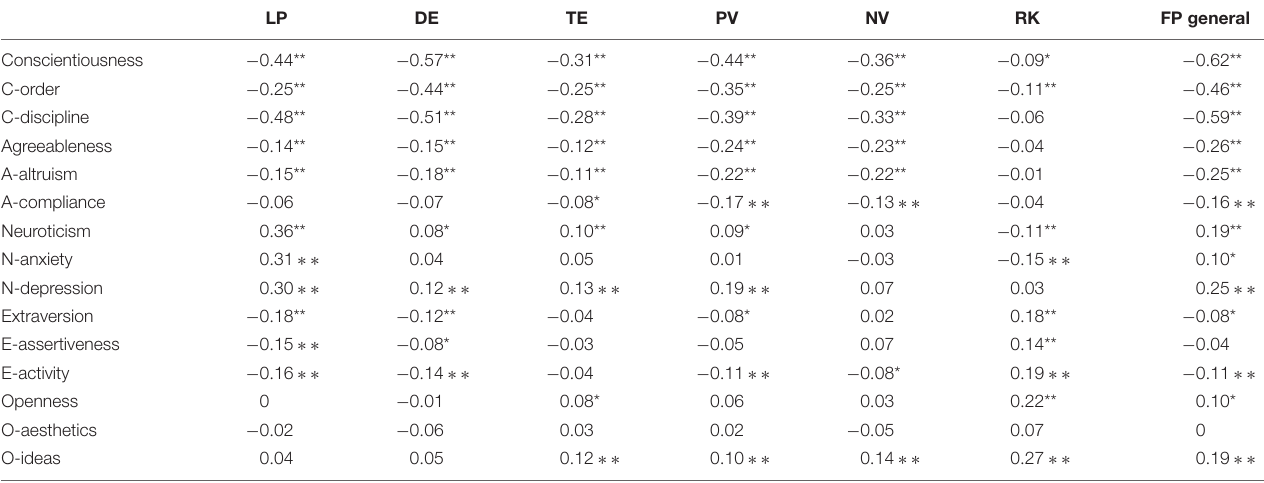
TABLE 6 | Correlations among BFI (traits and facets) and FP